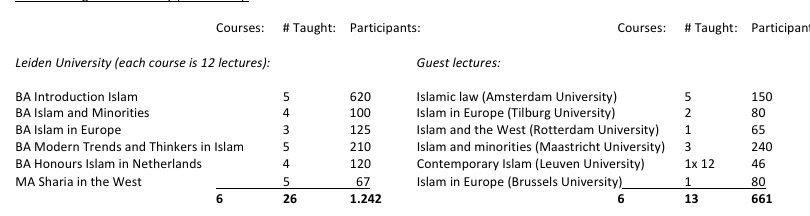
Figure 1. Courses taught in university (2014–2019).